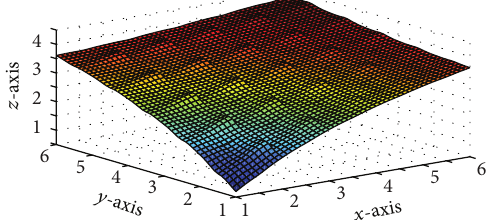
Figure 7: 𝐶 1 rational trigonometric bicubic function with 𝛼 𝑖,𝑗 = = 8 , 𝛾 = 5 , 𝛿 = 7 , 𝛼 = 14 , 𝛽 = 8 , 𝛾 14 , 𝛽 𝑖,𝑗 𝑖,𝑗 𝑖,𝑗 𝑖,𝑗+1 𝑖,𝑗+1 6 , 𝛿 = 13 , ̂𝛼 = 12 , ̂𝛽 = 9 , ̂𝛾 = 8 , ̂𝛿 = 8 , ̂𝛼 𝑖,𝑗+1 𝑖,𝑗 𝑖,𝑗 𝑖,𝑗 𝑖,𝑗 15 , ̂𝛽 = 9 , ̂𝛾 = 8 , ̂𝛿 = 8 . 𝑖+1,𝑗 𝑖+1,𝑗 𝑖+1,𝑗